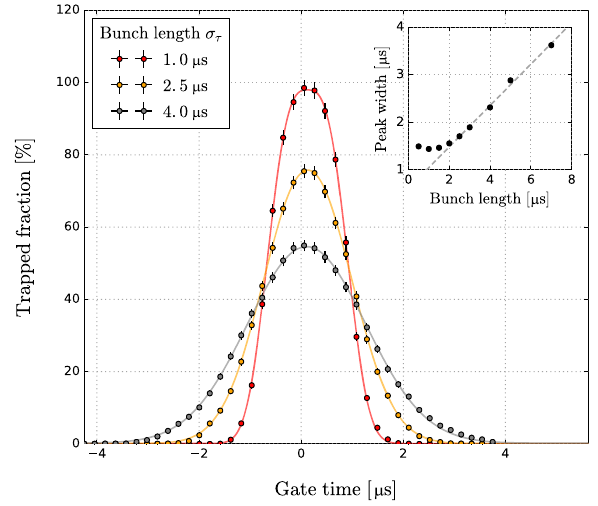
FIG. 10. Simulation showing the fraction of antiprotons cap- tured from each ¯ p bunch as a function of the Penning trap gate time t . Curves are shown for a range of bunch lengths between gate 1 μ s ≤ σ ≤ 4 μ s. The horizontal axis has been shifted relative to τ the optimal gate time. The inset plot shows the widths of the fitted curves as a function of bunch